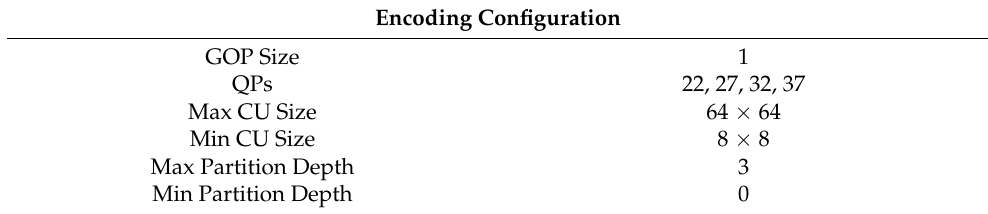
Table 1. Coding parameter configurations.